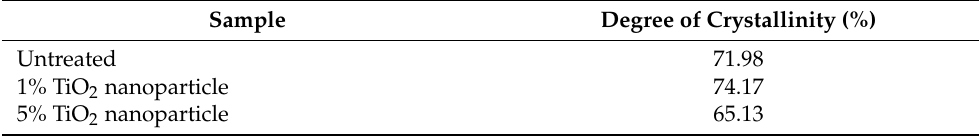
Table 3. Data on crystallinity test results for mangium wood impregnated with TiO 2